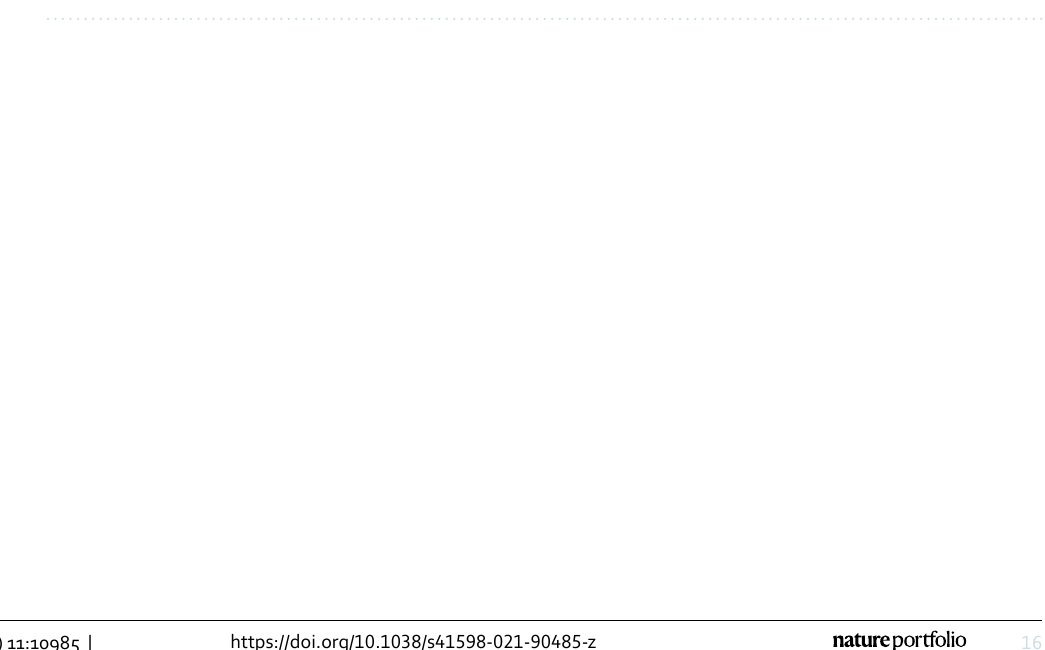
Table 3. Logic conditions of the combinatorial microfluidic circuit for all different input cases (scenarios) and the resulted